Question: What does this figure show? Answer in one sentence.
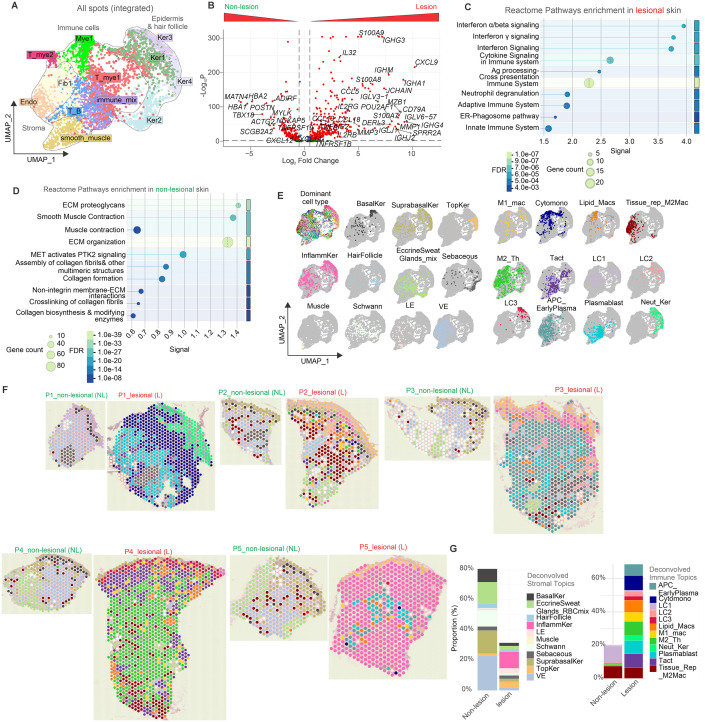
Answer: Global cellular heterogeneity and spatial organization in lesional vs non-lesional skin. (A) Uniform manifold approximation and projection (UMAP) of pooled non-lesional and lesional skin spots labelled by major skin domains inferred from gene expression. (B) Volcano plot of differentially expressed genes (UMAP) between non-lesional and lesional samples (red dots = adjusted P < 0.05, log2Fold > ± 0.25, -log10p > 10). (C, D) Top 10 Reactome pathways enriched in lesional (C) and non-lesional (D) skin. Bubble size = gene count; bars = signal strength (weighted harmonic mean of observed/expected ratio and -log (FDR); pathways grouped by similarity (Jaccard index ≥ 0.8, ranked by p-value). (E) UMAP coloured by dominant deconvoluted topic (highest proportion per spot) detected in each spot. (F) Spatial maps of non-lesional and lesional skin (P1-P5) coloured by dominant topic per spot. (G) Relative proportions of stromal (right) and immune (right) topic in non-lesional and lesional skin. All panels show pooled data from n=10 sections (5, non-lesional and 5 lesional from 5 patients) except (F) , which shows individual patient maps.